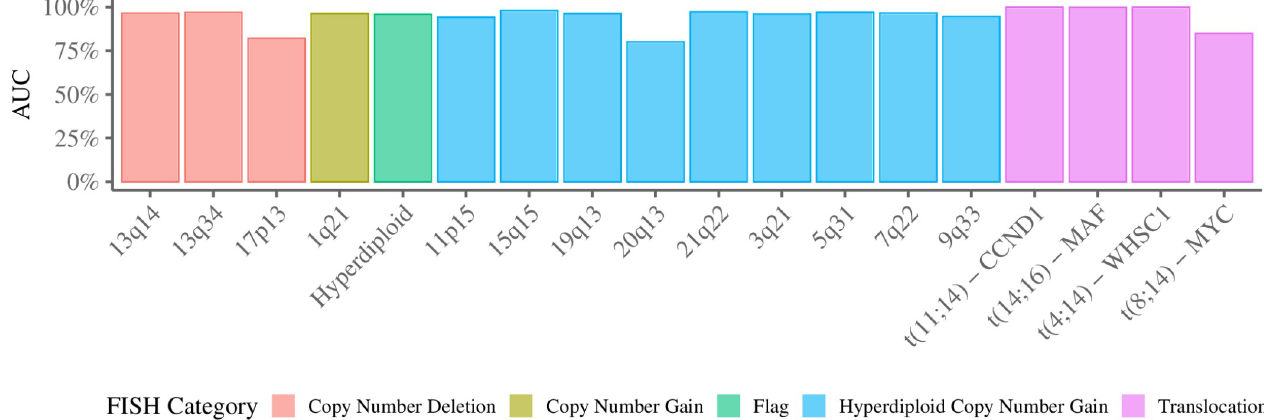
Fig 1. Average AUC of FISH predictors in 10-fold CV experiments. Hyperdiploid flag indicates if patients have at least two gains in the hyperdiploid gain regions [13].